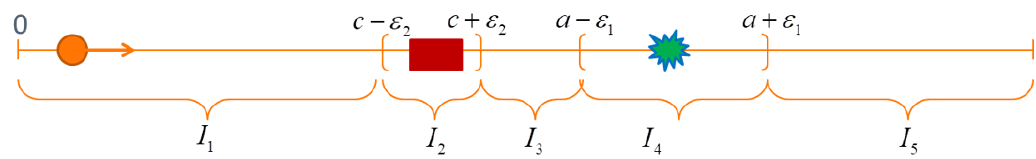
Fig. 3. Schematic presentation of the model system with one target domain and one